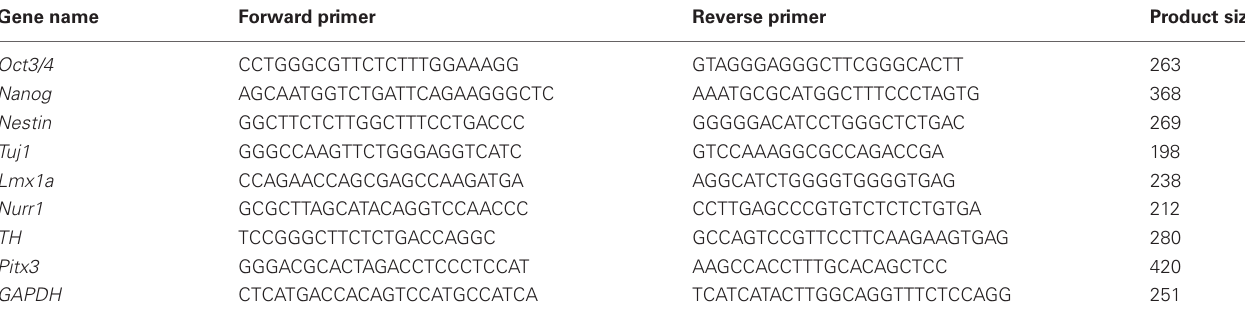
Table 1 | Summary of primers for